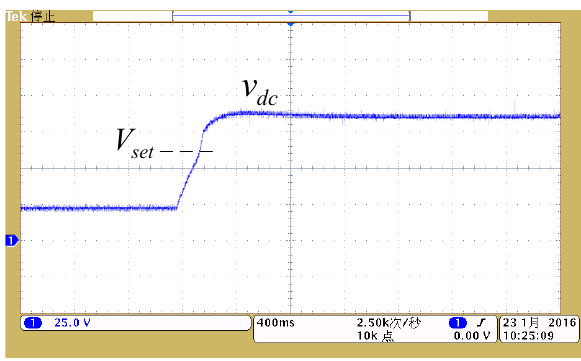
Figure 9. Start ‐ up process of dc ‐ link voltage. Figure 9. Start-up process of dc-link voltage.